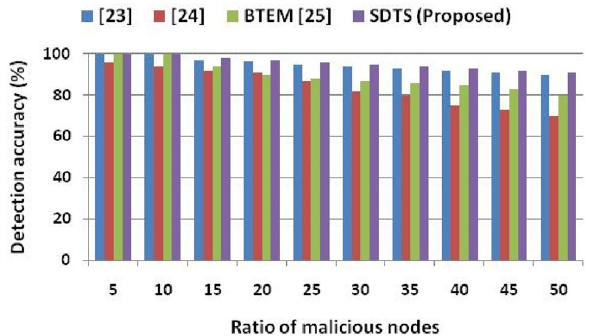
Figure 8. Ratio of malicious nodes vs. detection accuracy.